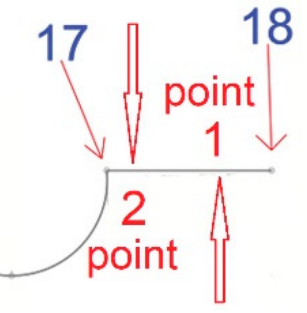
Figure 14. The locations for measuring the surface roughness (Points 1 and 2) at 500 and 12,000 mm/min on a straight part of the cutting path.